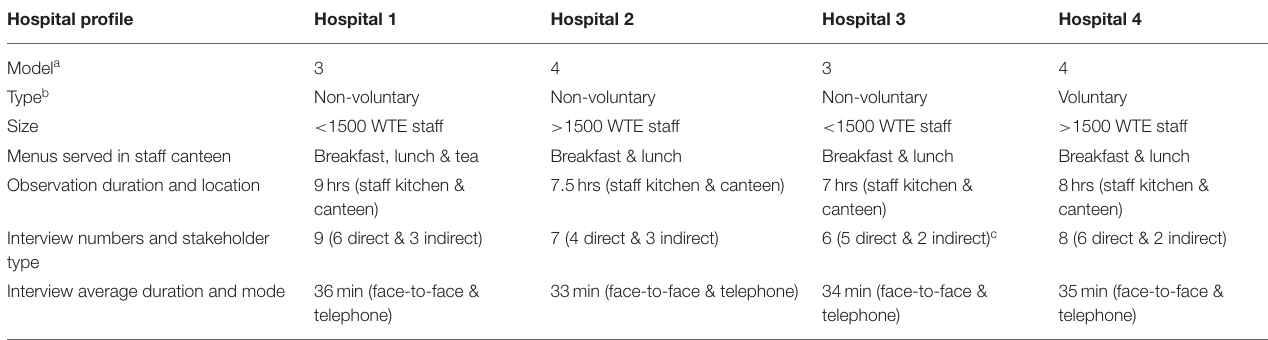
TABLE 1 | Hospital profiles and unstructured observation/interview